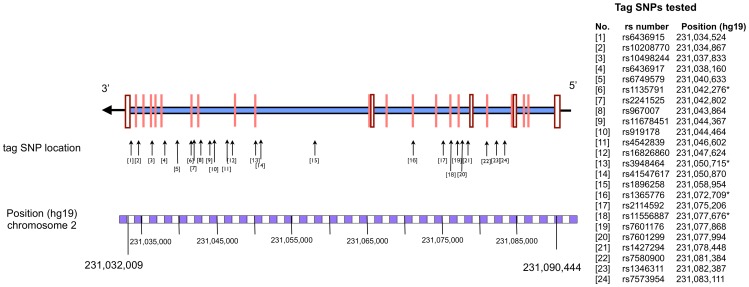
Human SP110 genomic structure showing the location of tested tag SNPs.